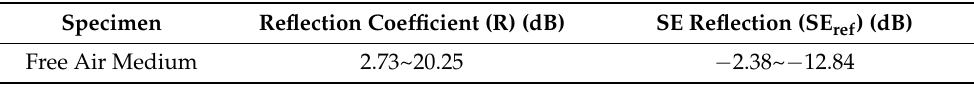
Table 5. Diagnostic calculation of Reflection Coefficient (R) and Shielding Effectiveness Reflection (SE ref ) from Equations (1) and (4).